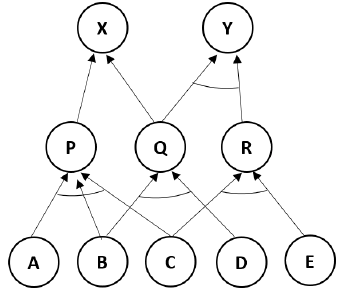
Figure 8. An example of an AND / OR inference network (reproduced from [61]).